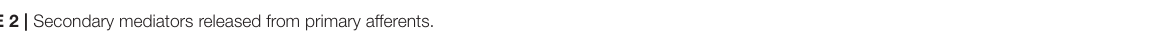
TABLE 2 | Secondary mediators released from primary